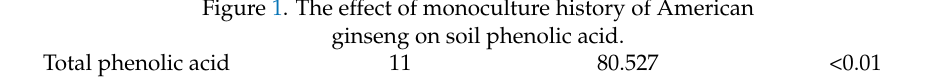
Figure 1. The effect of monoculture history of American ginseng on soil phenolic